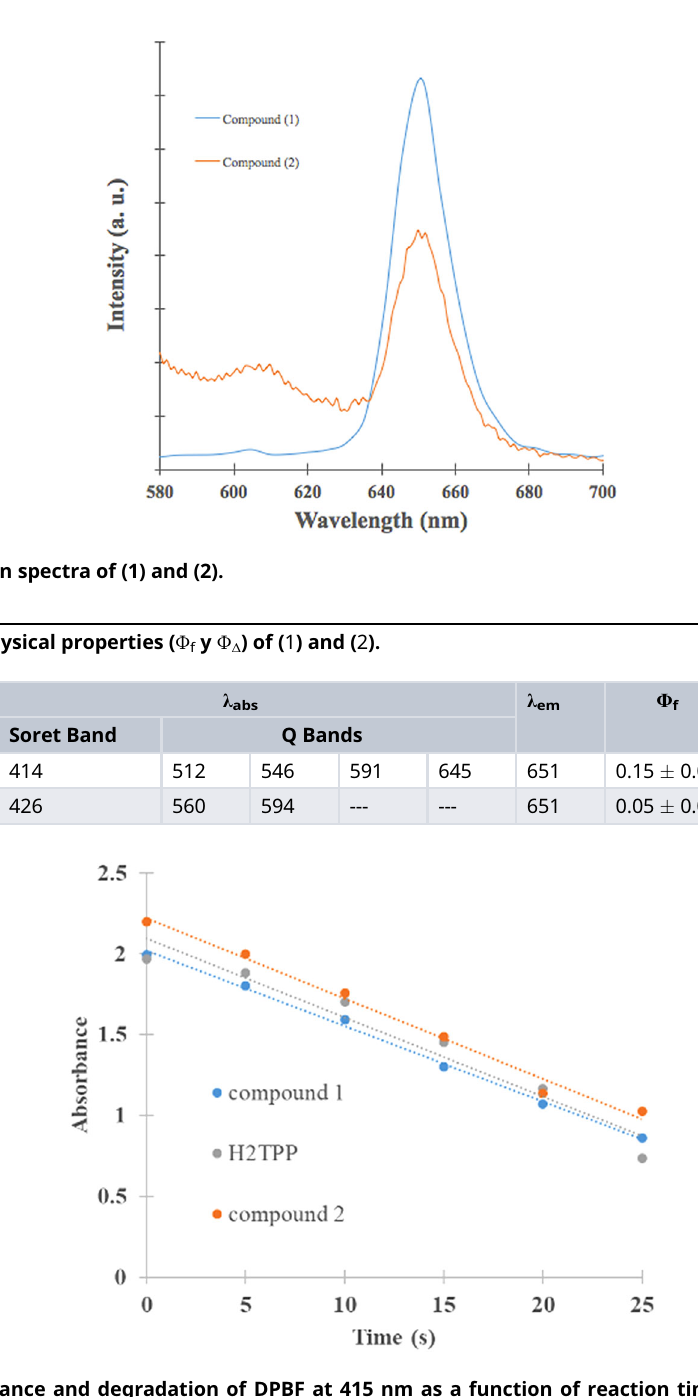
Figure 4. Absorbance and degradation of DPBF at 415 nm as a function of reaction time with ( 1 ), ( 2 ) and standard. Linear fit is also